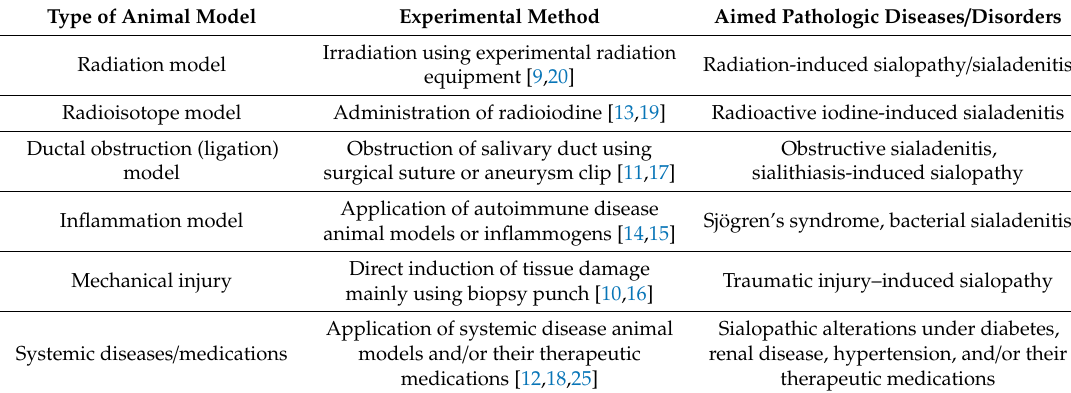
Table 1. Summary of the experimental animal models mimicking sialopathies.